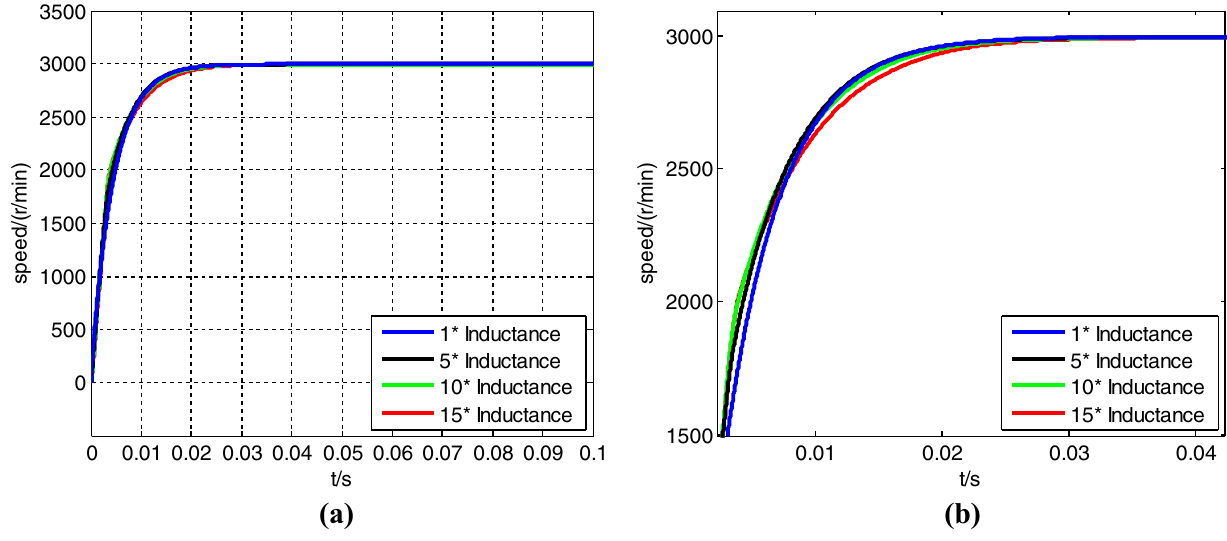
Fig. 12 The comparison of speed tracking with varying inductance: a speed response curve of 0–0.1 s, b transient speed response curve of 0–0.05